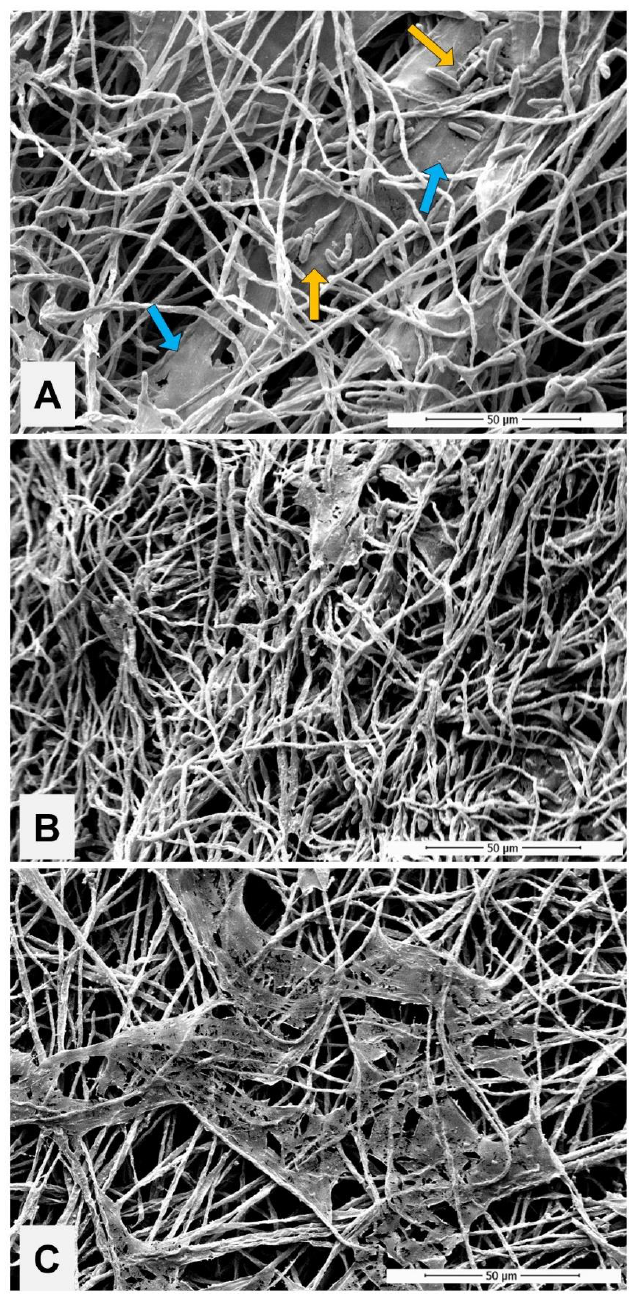
Figure 6. Seven-day biofilm produced by Neocosmospora keratoplastica on polystyrene plate. ( A ) Mor- phology of the control biofilm presenting a dense tangle of hyphae, conidia (yellow arrow) and the presence of intense extracellular matrix (blue arrow); ( B ) biofilm exposed to propolis extract showed a drastic reduction in matrix and conidia but maintained its architecture; ( C ) biofilm exposed to propolis gel evidencing a reduction in hyphae and conidia and a torn extracellular matrix. SEM images at 2000× magnification.